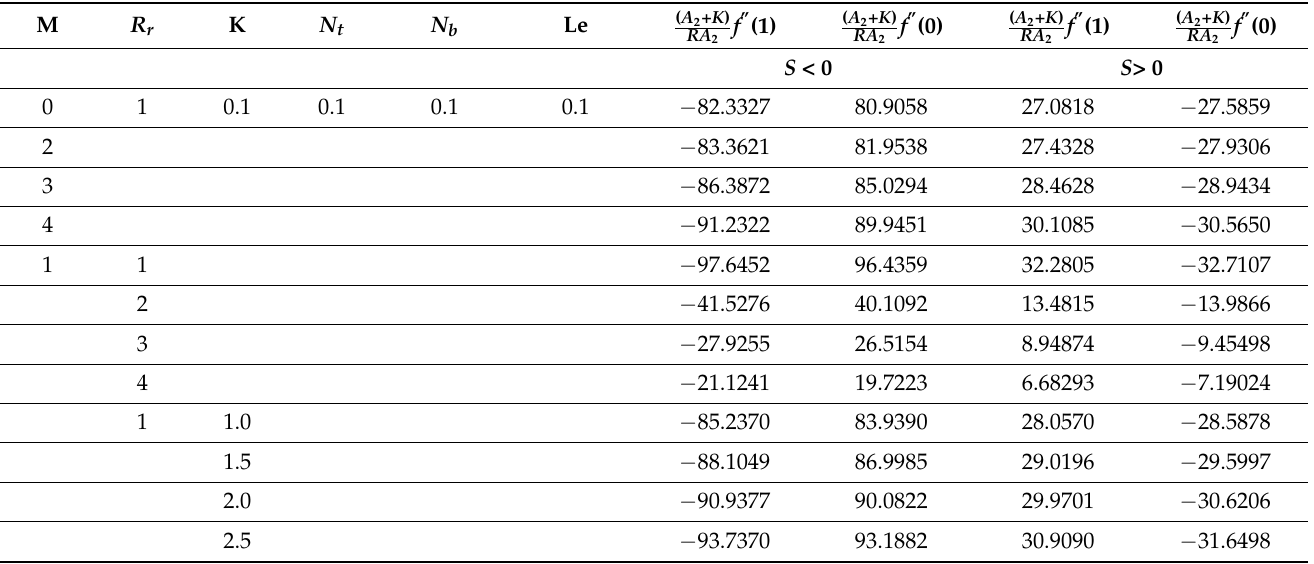
Table 5. Skin friction coefficient for ( γ Al 2 O 3 − C 2 H 6 O 2 ) , at lower and upper plane with weak interaction n =